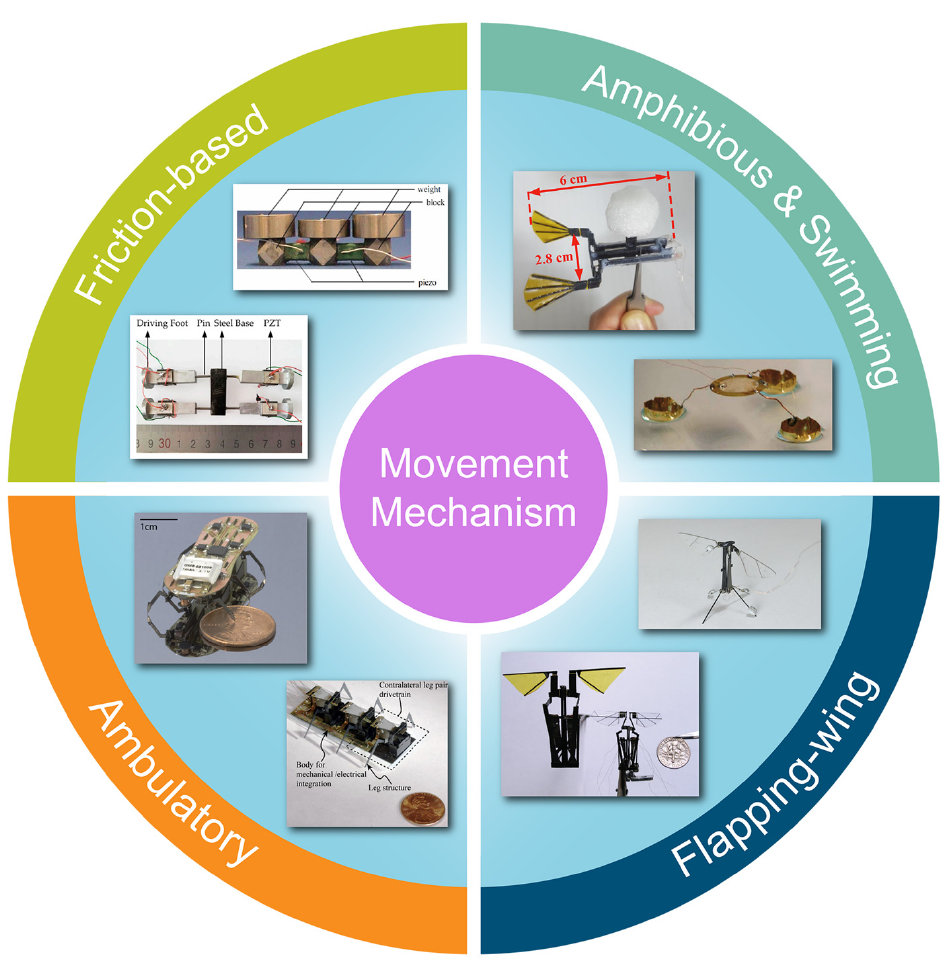
Figure 1. Categories defined for the movement mechanisms of microrobots. Reprinted with permission from Ref. [15]. Copyright 2011, IEEE. Reprinted with permission from Ref. [31]. Copyright 2018, MDPI. Reprinted with permission from Ref. [32]. Copyright 2021, Elsevier. Reprinted with permission from Ref. [18]. Copyright 2013, Springer. Reprinted with permission from Ref. [33]. Copyright 2012, SAGE. Reprinted with permission from Ref. [34]. Copyright 2017, IEEE. Reprinted with permission from Ref. [35]. Copyright 2010, IEEE. Reprinted with permission from Ref. [36]. Copyright 2011, IEEE.